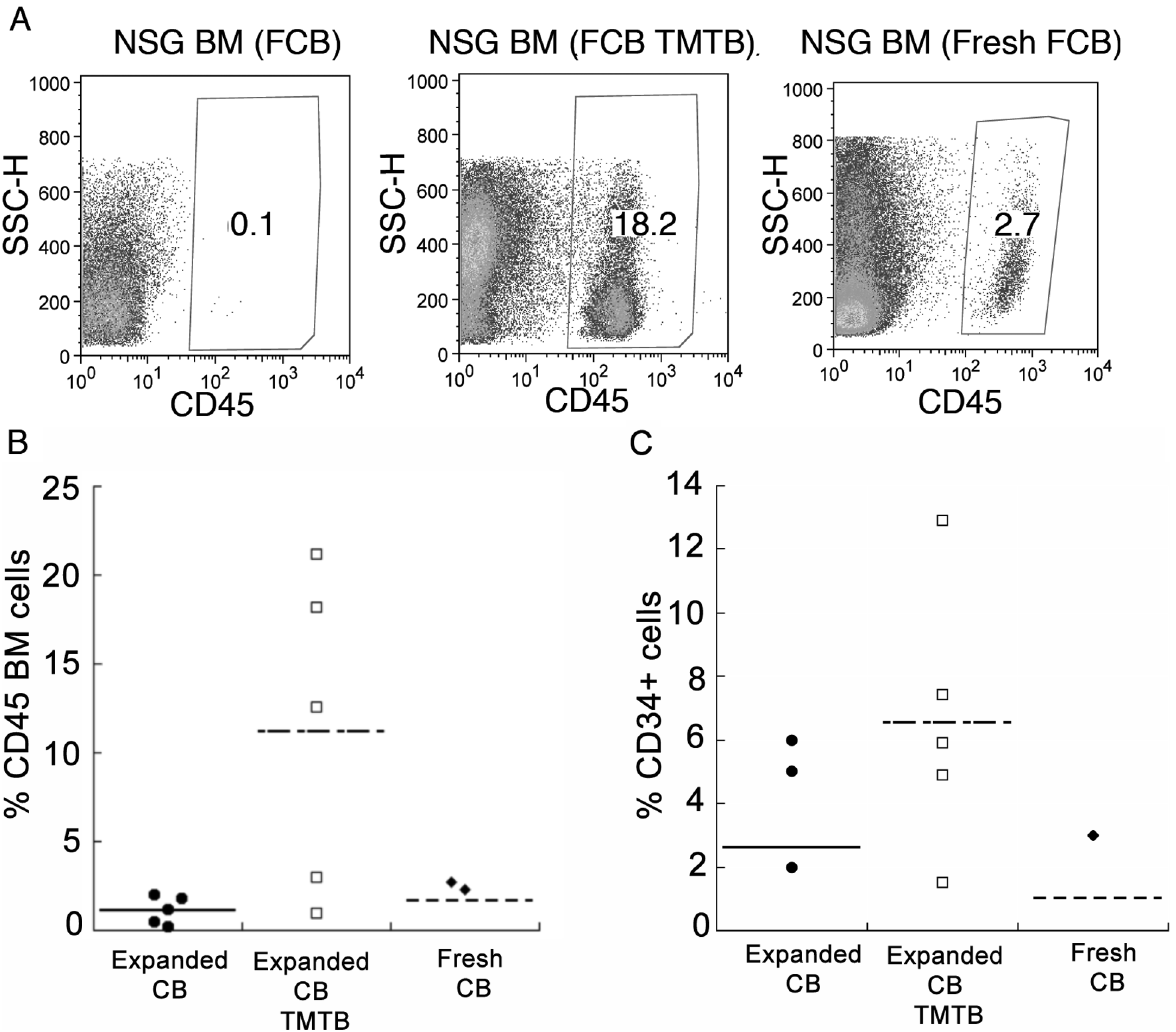
Figure 6. Comparison of NSG mouse engraftment with human cord blood cells expanded with Tat-MYC/Tat-Bcl-2 or fresh cord blood. A. hCD45 + cell staining in the BM of sublethally irradiated NSG mice were given transplants of 10 6 cord blood cells expanded ex vivo in a cocktail of cytokines (first panel), expanded in a cocktail of cytokines supplemented with Tat-MYC/Tat-Bcl-2 (second panel), or 1 6 10 7 fresh unmanipulated cord blood cells (third panel). B. A dot plot showing BM cells from a cohort of NSG xenochimaeric mice transplanted of 10 6 cord blood cells expanded ex vivo in a cocktail of cytokines (black circles), expanded in a cocktail of cytokines supplemented with Tat-MYC/Tat-Bcl-2 (open squares), or 1 6 10 7 fresh unmanipulated cord blood cells (black diamonds) were stained for human CD45. C. A dot plot shown human CD34 + /CD38 + cells in the bone marrow 3/5 mice transplanted with cord blood expanded in cytokines alone (black circles), CD34 + /CD38 + cells in the bone marrow of 5/5 mice transplanted with cord blood expanded in cytokines plus Tat-MYC/Tat-Bcl-2 (open squares), and CD34 + /CD38 + cells in the bone marrow of 1 out of 3 mice transplanted with unmanipulated cord blood (black diamonds). doi:10.1371/journal.pone.0105525.g006 population of bone marrow cells (Figure 8F) and spleen cells (Figure 8G) were analyzed for human CD11b, CD33, CD3, and CD19 expression. Both myeloid (CD11b and CD33) and lymphoid (CD3 and CD19) cell differentiation markers were observed in the bone marrow and spleen of these xenochimaeric mice.